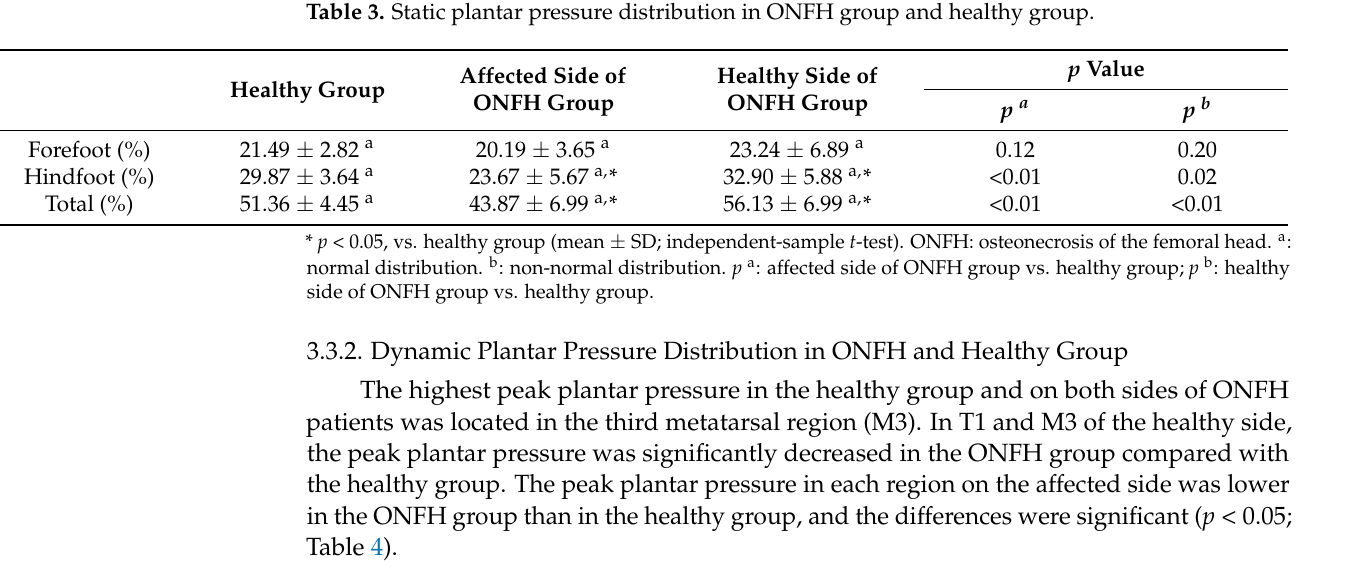
Table 4. Dynamic plantar pressure distribution in ONFH group and healthy